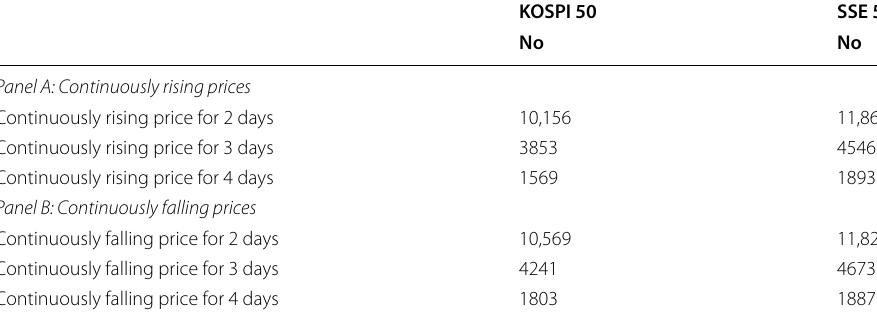
This table lists the numbers of continuously rising (falling) prices for 2, 3, and 4 days emitted for the constituent stocks of KOSPI 50 and SSE 50 over the data period 2009–2015 continuous rising (falling) price sample as 3 or more days after the previous sample as counted. Lastly, we consider another 4-day continuous rising (falling) price sample as 4 or more days after the previous sample as